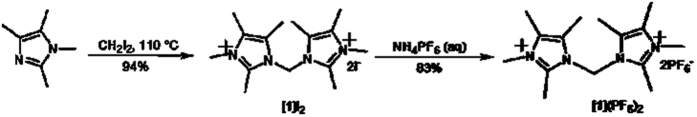
Synthesis of [1](PF6)2.